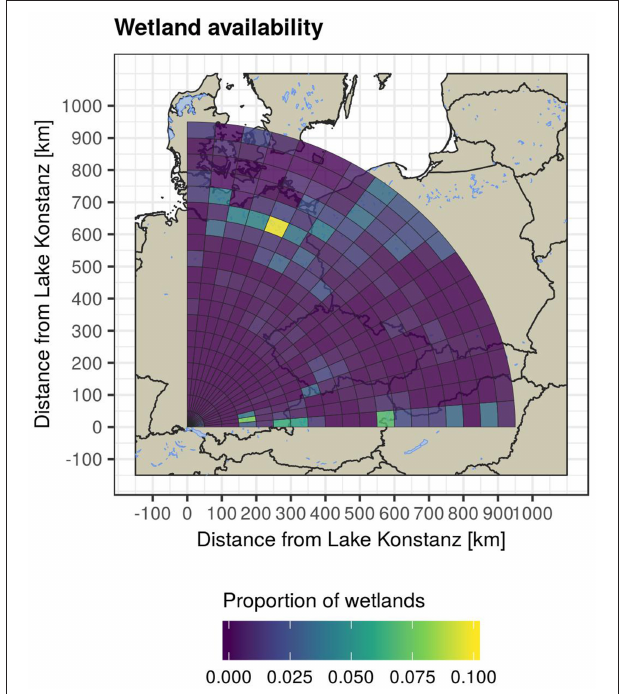
FIGURE 6 | Wetland availability within the reach of mallard spring migration from Lake Constance, expressed as the area-percentage of freshwater habitat within each annulus section. Note that the availability of wetlands is generally low, making it unlikely for seeds to end up in wetland habitat when excreted during the mallard migratory